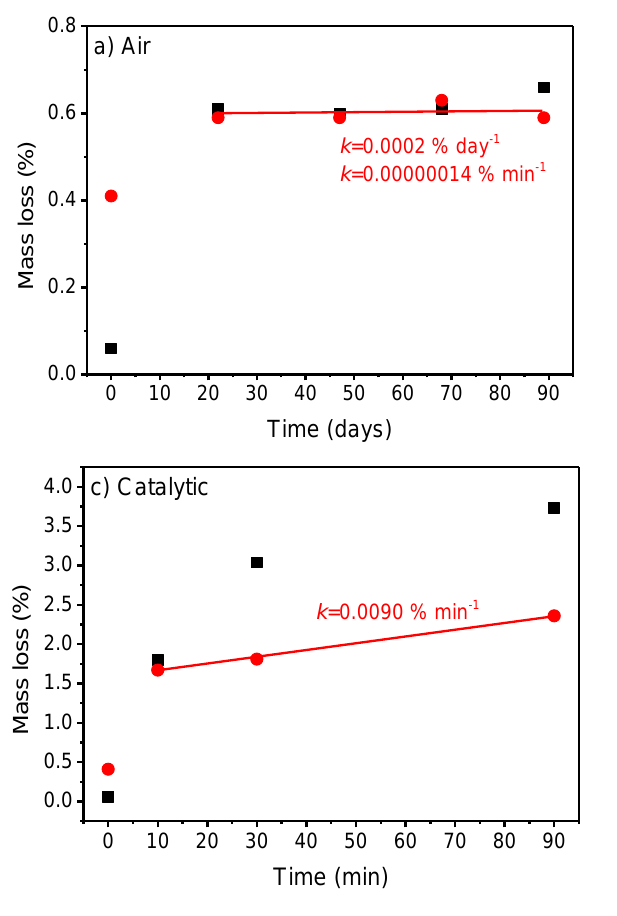
Figure 5. Mass loss of SCF samples stored in in ( a ) air and ( b ) water, and ( c ) used as catalysts for the temperature regions 50–360 ◦ C (symbol (cid:4) ) and 610–900 ◦ C (symbol • ) determined by TGA measurements. Lines are linear fits to determine the kinetic constant k after initial carbonate formation. The two kinetic constants k in ( a ) are calculated for same data with different units. Note the difference in scale between the x – axis and y – axis. Table 2. Calculated mass losses in different temperature ranges after storage of SCF in air, dispersed in water, and used as catalyst for degradation of bisphenol A. The fraction of blocked Sr-sites n SrCO3 is calculated based on the mass losses.